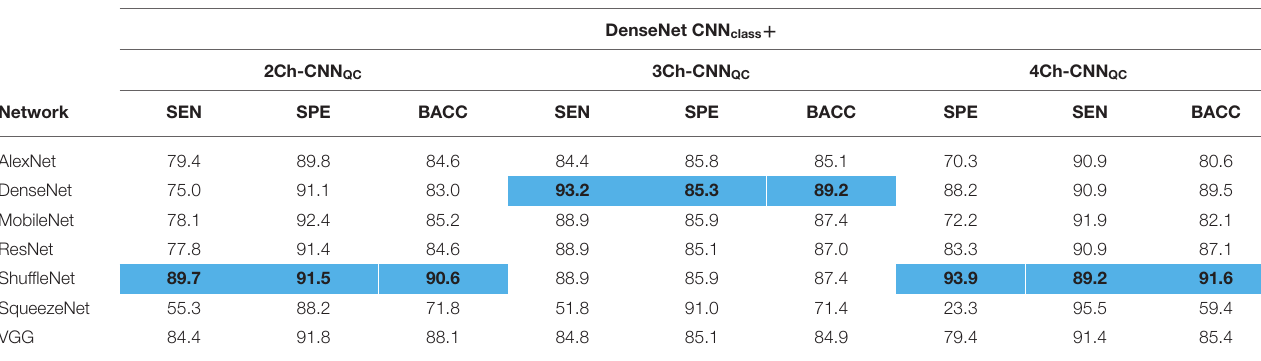
TABLE 4 | Framework validation.